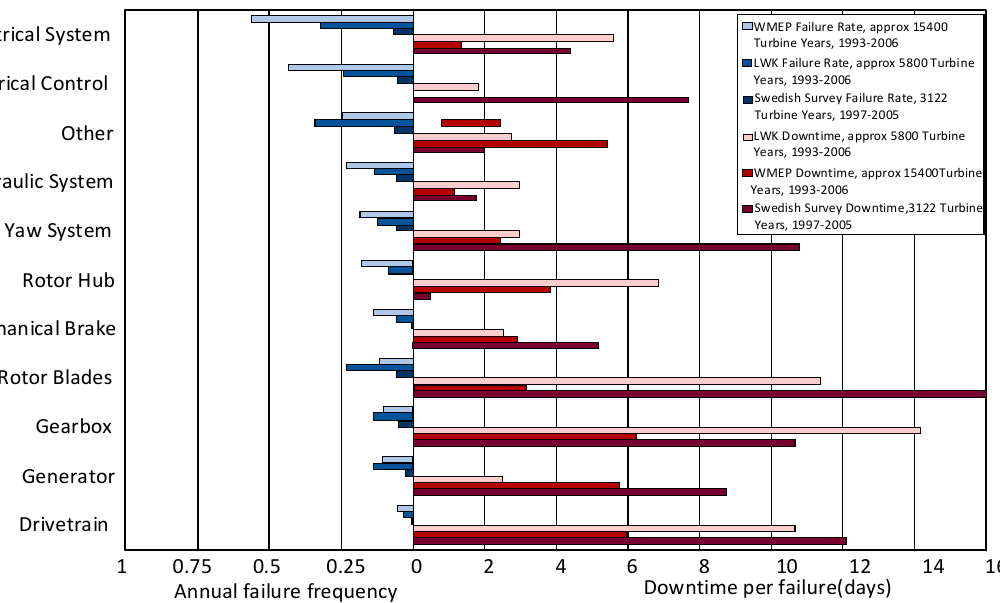
Figure 5. Annual failure rate and downtime per failure for surveyed wind farms in Europe [5].